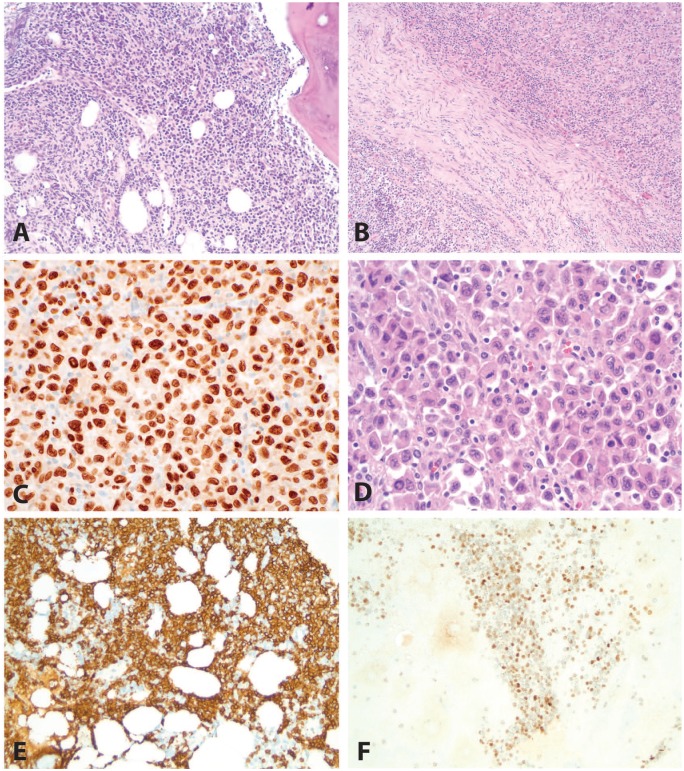
Case 3: low-grade follicular lymphoma and Langerhans cell sarcoma. This case shows a low-grade follicular lymphoma (A, H&E, 200× and B, H&E, 100×) in association with Langerhans cell sarcoma (B, H&E, 100× and D, H&E, 400×). A PU.1 immunohistochemical stain (C, 400×) demonstrates more intense expression in the Langerhans cell sarcoma than in the follicular lymphoma. The low-grade B-cell lymphoma was positive for CD20 (E, 200×) and BCL6 (F, 200×). H&E indicates hematoxylin and eosin.